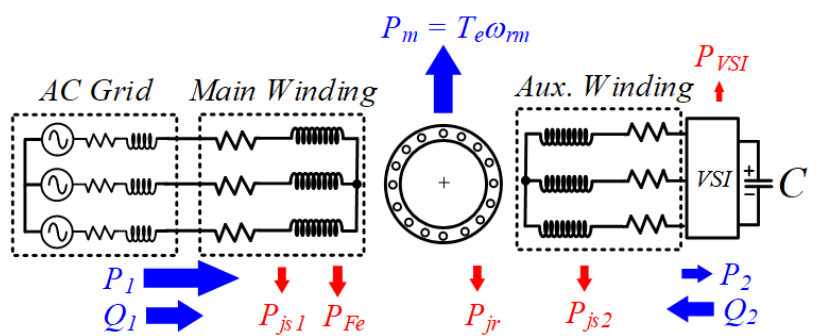
Figure 7. Power flow scheme of the DWIM.